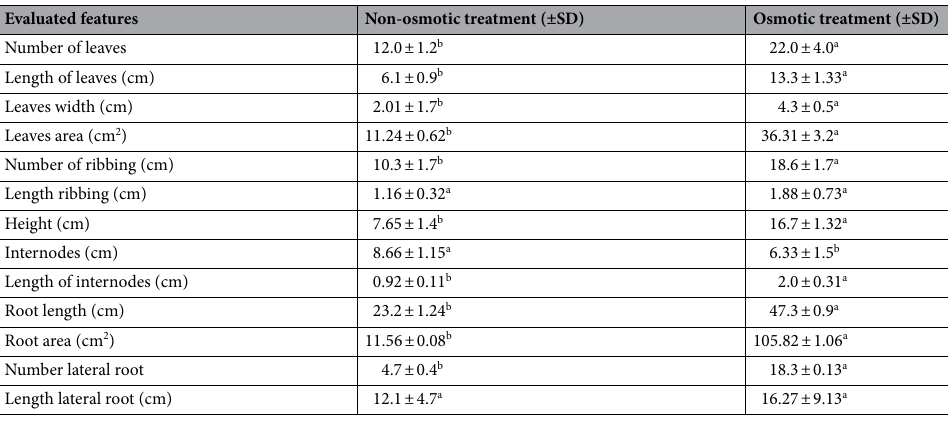
Table 2. Morphological differences between plants of C. arabica var. Typica regenerated from mature SEs produced in SE-M9 (osmotic medium) and SE-M3 (non-osmotic) medium after eight months. Differences in variables among treatments were tested using factorial analysis of variance (ANOVA). Values are means ± standard deviation. In each row, means followed by different letters are significantly different (P < 0.05). SE-M3 non-osmotic medium (control) and SE-M9 osmotic medium. Software